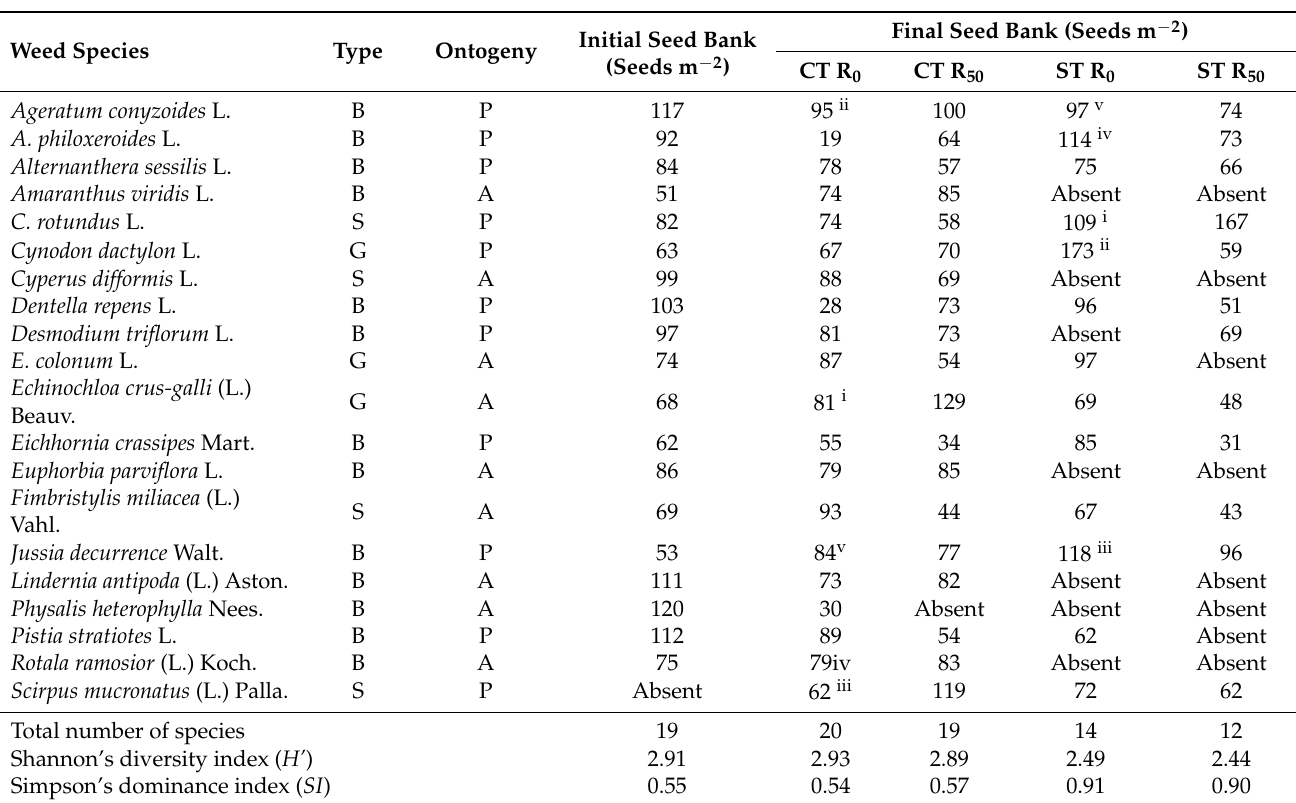
Table 5. Composition of initial and final soil seed bank at 10–15 cm depth under different treatments (average for wheat- mungbean-monsoon rice and monsoon rice-mustard-winter rice rotation). Final Seed Bank (Seeds m − 2 ) Initial Seed Bank Weed Species Type Ontogeny (Seeds m − 2 ) CT R 0 CT R 50 ST R 0 ST R 50 Ageratum conyzoides L. B P 117 95 ii 100 97 v 74 A. philoxeroides L. B P 92 19 64 114 iv 73 Alternanthera sessilis L. B P 84 78 57 75 66 B A 51 74 85 Absent Absent S P 82 74 58 109 i 167 Cynodon dactylon L. G P 63 67 70 173 ii 59 Cyperus difformis L. S A 99 88 69 Absent Absent Dentella repens L. B P 103 28 73 96 51 Desmodium triflorum L. B P 97 81 73 Absent 69 E. colonum L. G A 74 87 54 97 Absent Echinochloa crus-galli (L.) G A 68 81 i 129 69 48 Beauv. Eichhornia crassipes Mart. B P 62 55 34 85 31 Euphorbia parviflora L. B A 86 79 85 Absent Absent Fimbristylis miliacea (L.) S A 69 93 44 67 43 Vahl. Jussia decurrence Walt. B P 53 84 v 77 118 iii 96 Lindernia antipoda (L.) Aston. B A 111 73 82 Absent Absent Physalis heterophylla Nees. B A 120 30 Absent Absent Absent Pistia stratiotes L. B P 112 89 54 62 Absent Rotala ramosior (L.) Koch. B A 75 79iv 83 Absent Absent Scirpus mucronatus (L.) Palla. S P Absent 62 iii 119 72 62 Total number of species 19 20 19 14 12 Shannon’s diversity index ( H’ ) Simpson’s dominance index ( SI